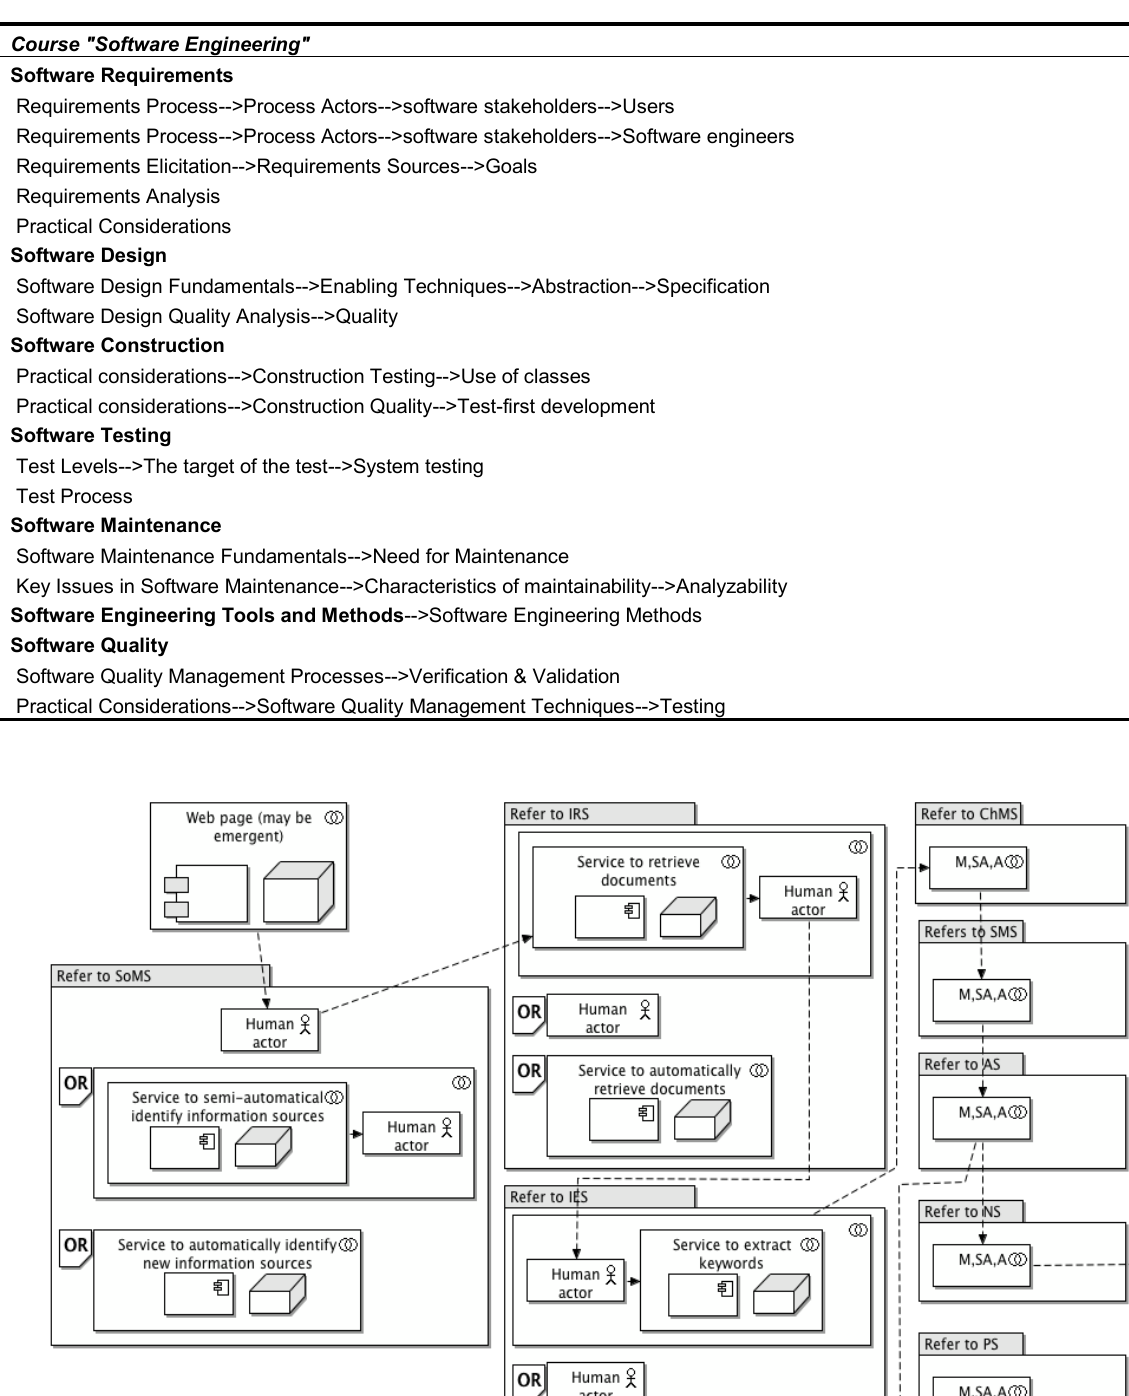
Table 5. Example of correspondence between course "Software Engineering" and SWEBOK